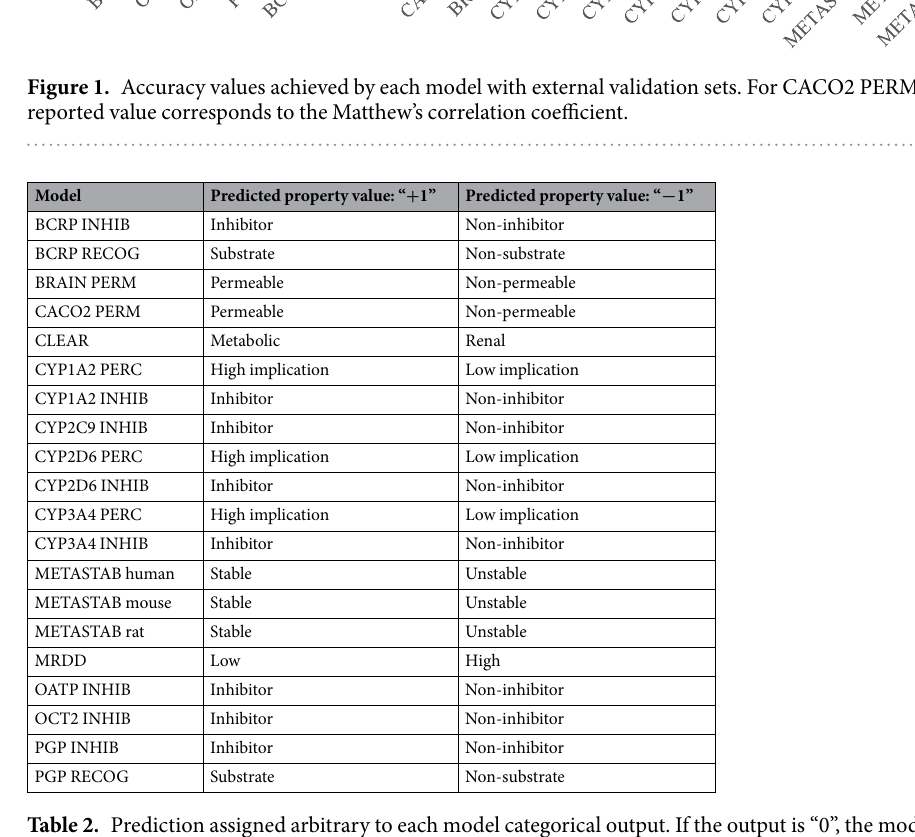
Table 2. Prediction assigned arbitrary to each model categorical output. If the output is “0”, the model was not able to classify the molecule, and the predicted class is